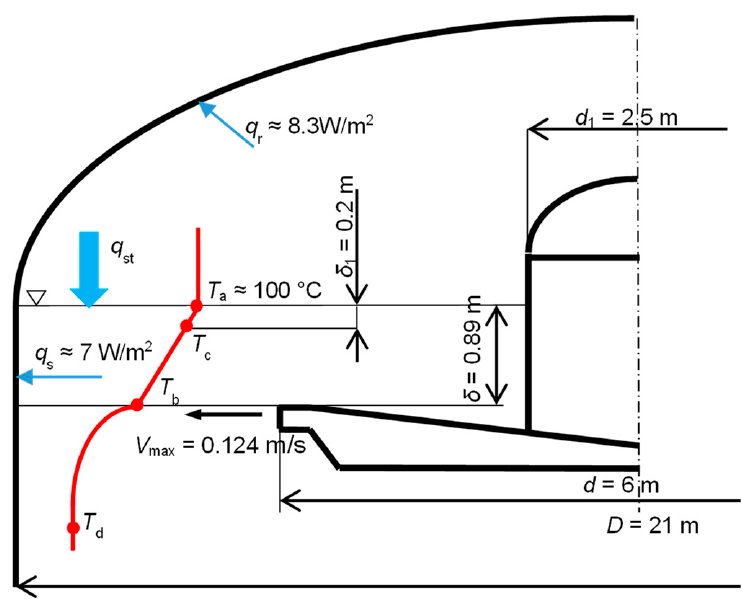
Figure 9. Assumption for mathematical model for steam cushion system in Białystok CHP plant. The calculation of heat losses by the shell tank with the height equal δ was carried out for shell insulation materials glass wool [ λ ins ≈ 0.05 W/(m · K)], and thickness of insulation equals 500 mm. The unit heat loss for the above conditions is approximately 7.0 W/m 2 , which, for a cylindrical shell of approximately 58 m 2 , gives a total heat loss through the shell of the tank with a height of 0.89 m of about 0.4 kW (see Table 1 and Figure